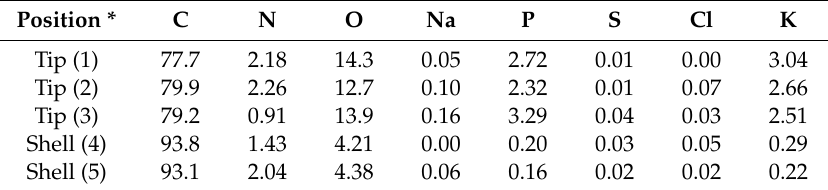
right of the corresponding STEM image.